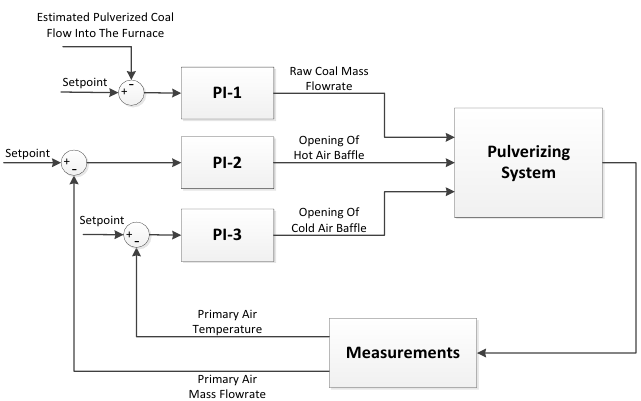
Figure 11. Conventional PI control structure.